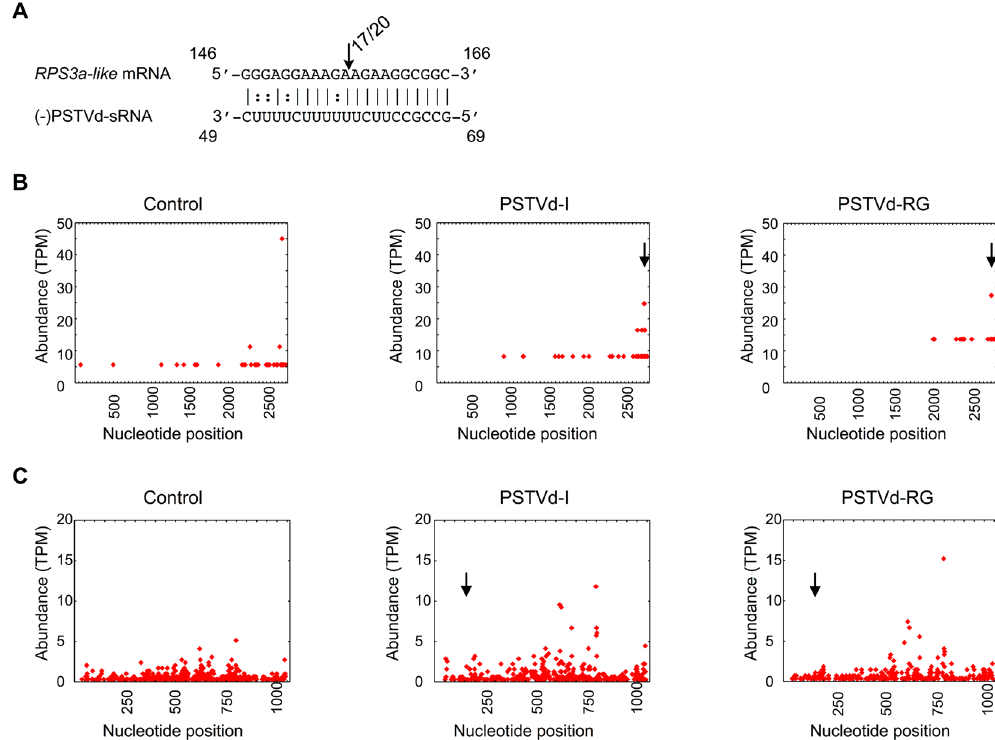
Figure 5. Analysis of RISC-Mediated Cleavage of the CLC-b-like and RPS3a-like mRNA by RLM RACE. ( A ) RPS3a-like mRNA/vd-sRNA duplexes predicted to be formed by the sRNA derived from the PSTVd variants. The arrows indicate the 5 ′ termini of RPS3a-like mRNA fragments isolated from the PSTVd-infected plants, as identified by 5 ′ RLM-RACE products, with the frequency of clones shown. (i.e. 17/20, indicates that 17 cleavage products were found out of 20 analyzed clones). Sequences are shown in the complementary polarity. The PARE reads were profiled against ( B ) the chloride channel protein CLC-b-like and ( C ) the RPS3a-like mRNAs. The vertical arrow denotes the predicted cleavage site. All of the reads were normalized to Transcripts Per Million (TPM). Note that different scales were